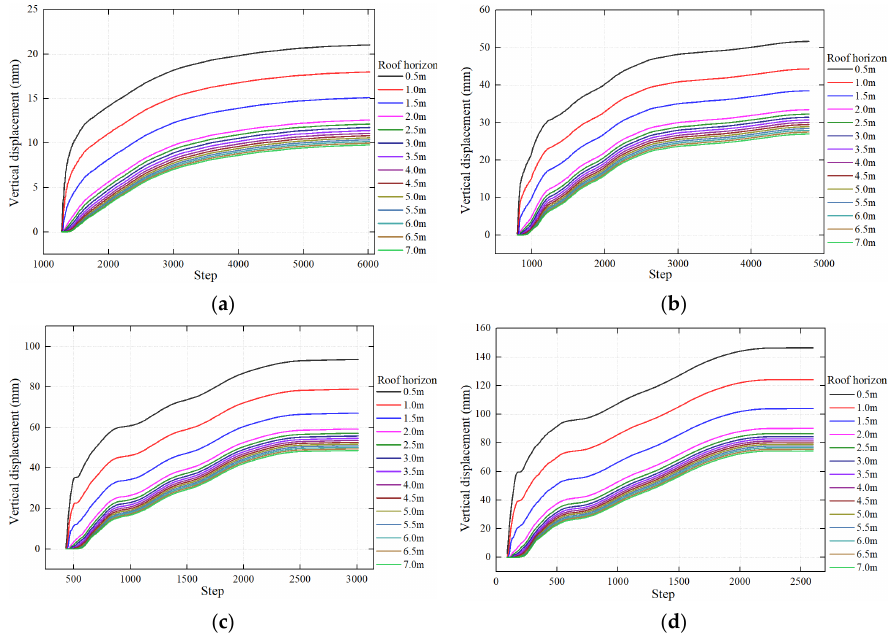
Figure 7. Displacement evolution of rock masses at different horizons of the roadway roof: ( a ) roadway at the buried depth of 200 m; ( b ) roadway at the buried depth of 400 m; ( c ) roadway at the buried depth of 600 m; ( d ) roadway at the buried depth of 800 m.